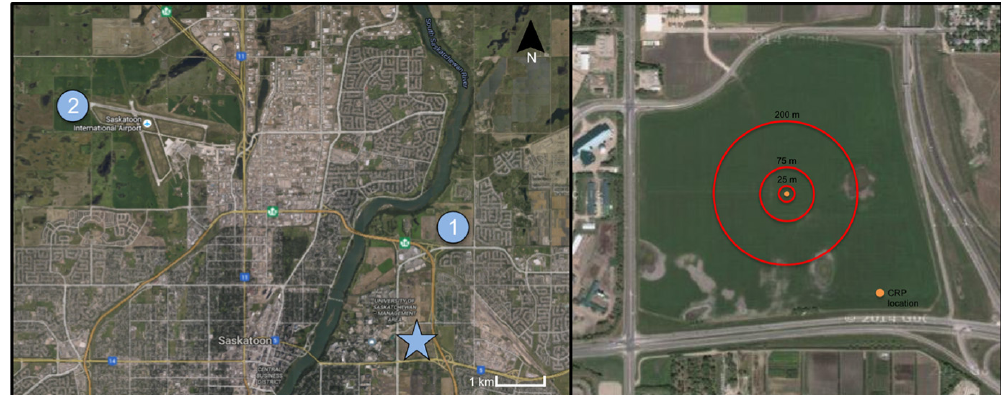
Figure 1. (Left) Location of main study site (star), RCS reference site (1), and Saskatoon Airport RCS reference site (2) in Saskatoon, SK, Canada. (right) Location of the CRP (orange dot) at the agriculture study site and the 25, 75, and 200m SWE sampling radials (red lines). Image from Google